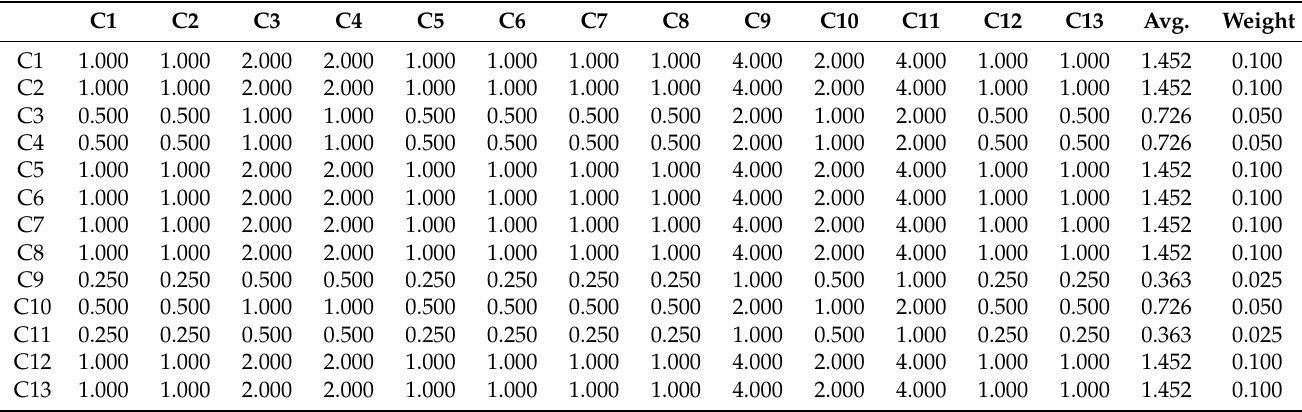
Table 10. Transformed comparison matrix of decision factors: the geometric mean of the rows and weights of decision factors (REMBRANDT method).